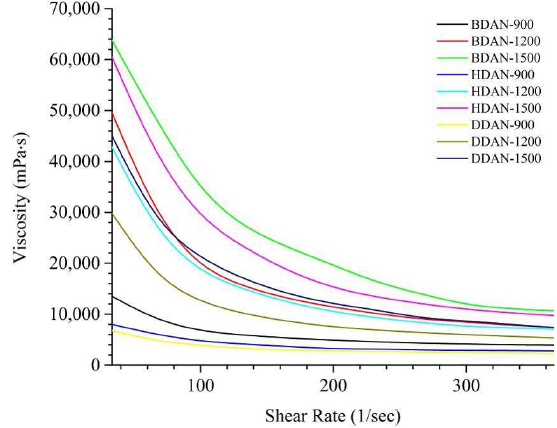
Figure 8. Viscosity value of OL-As at increasing shear rates.